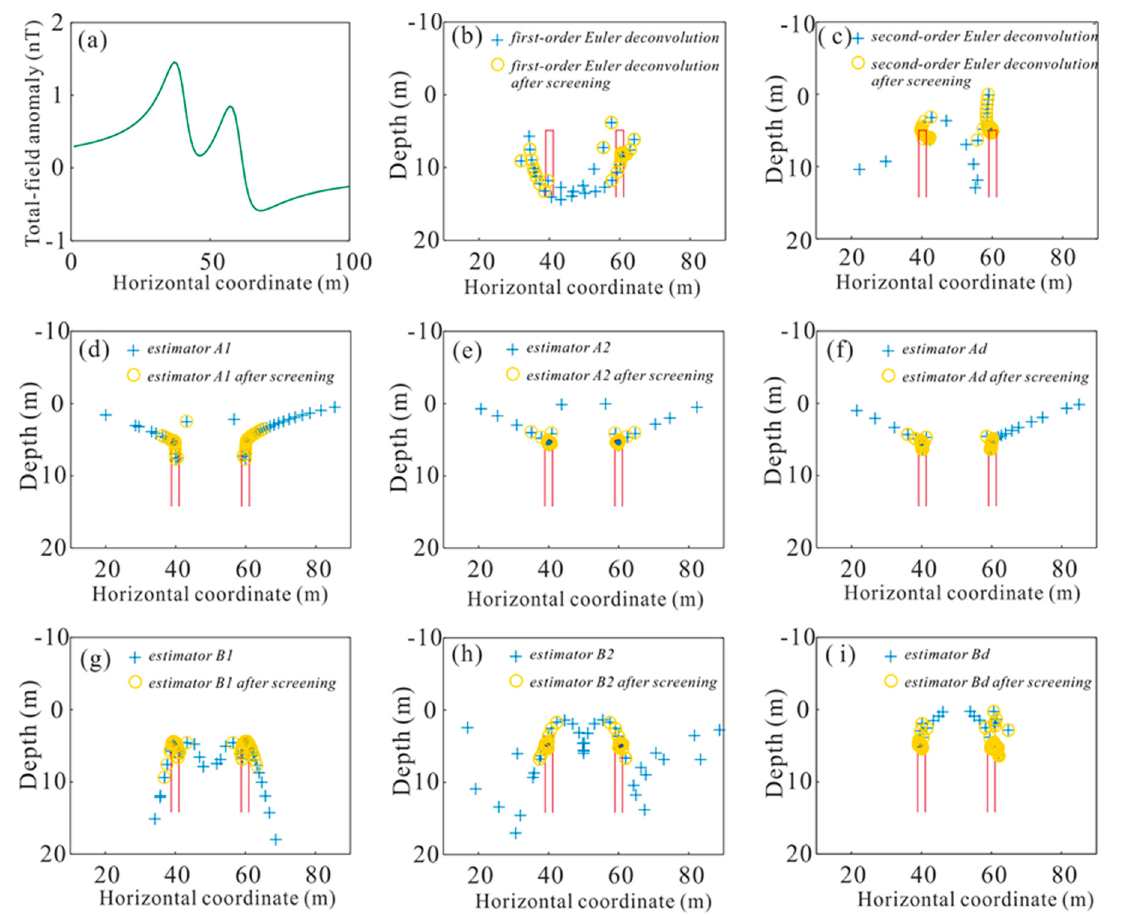
Figure 4. ( a ) Total magnetic anomaly of two infinite vertical sheets having a magnetic inclination of 60° and a declination perpendicular to strike; ( b ) source location results generated by first-order Euler deconvolution; ( c ) source location results generated by second-order Euler deconvolution; ( d ) source location results generated by estimator A1; ( e ) source location results generated by estimator A2; ( f ) source location results generated by estimator Ad; ( g ) source location results generated by estimator B1; ( h ) source location results generated by estimator B2; ( i ) source location results generated by estimator Bd.